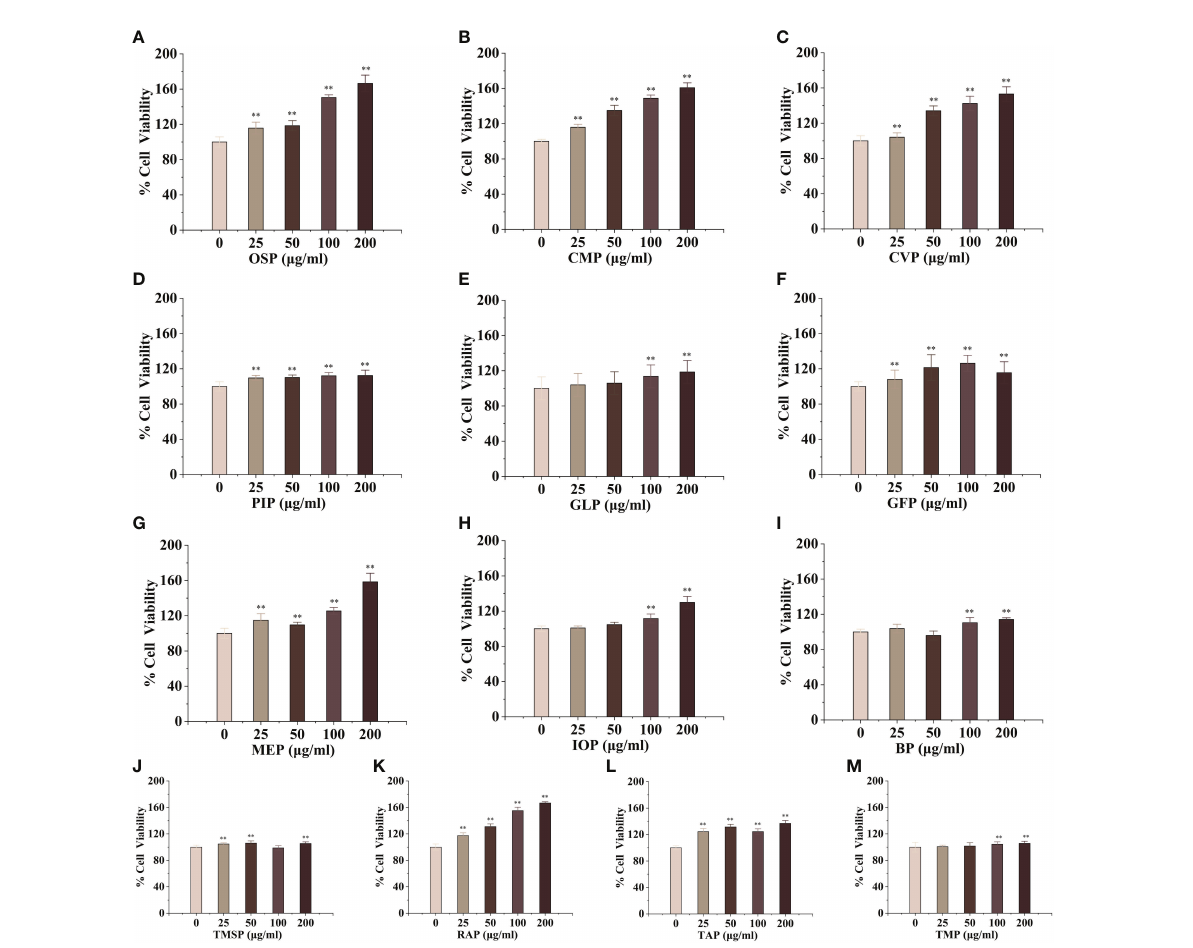
FIGURE 1 Proliferative effects of thirteen rare edible mushroom proteins on RAW 264.7 cells. OSP (A) , CMP (B) , CVP (C) , PIP (D) , GLP (F) , MEP (G) , IOP (H) , BP (I) , TMSP (J) , RAP (K) , TAP (L) , and TMP (M) on the proliferation of RAW 264.7 macrophages. Data are expressed as mean ± SD (n=5). **P < 0.01, compared with the control